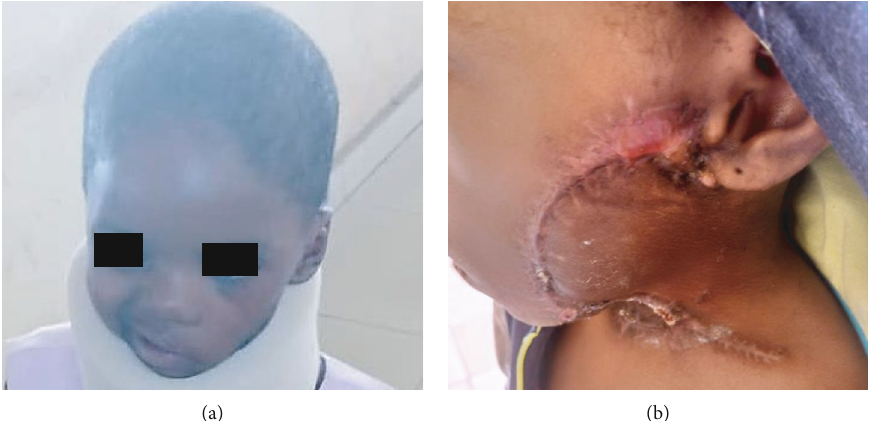
Figure 5: Nine weeks postsurgery clinical image of a female child diagnosed with a MAML2 -rearranged mucoepidermoid carcinoma of the parotid gland with a left facial nerve de fi cit (a) and healed reconstructive skin fl ap